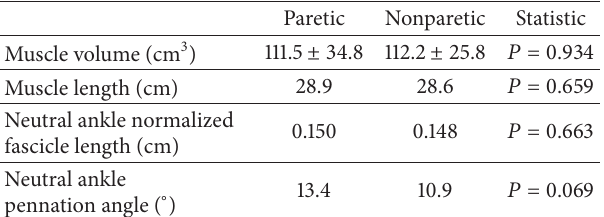
Table 2: Muscle parameter data and test statistics for the poststroke tibialis anterior